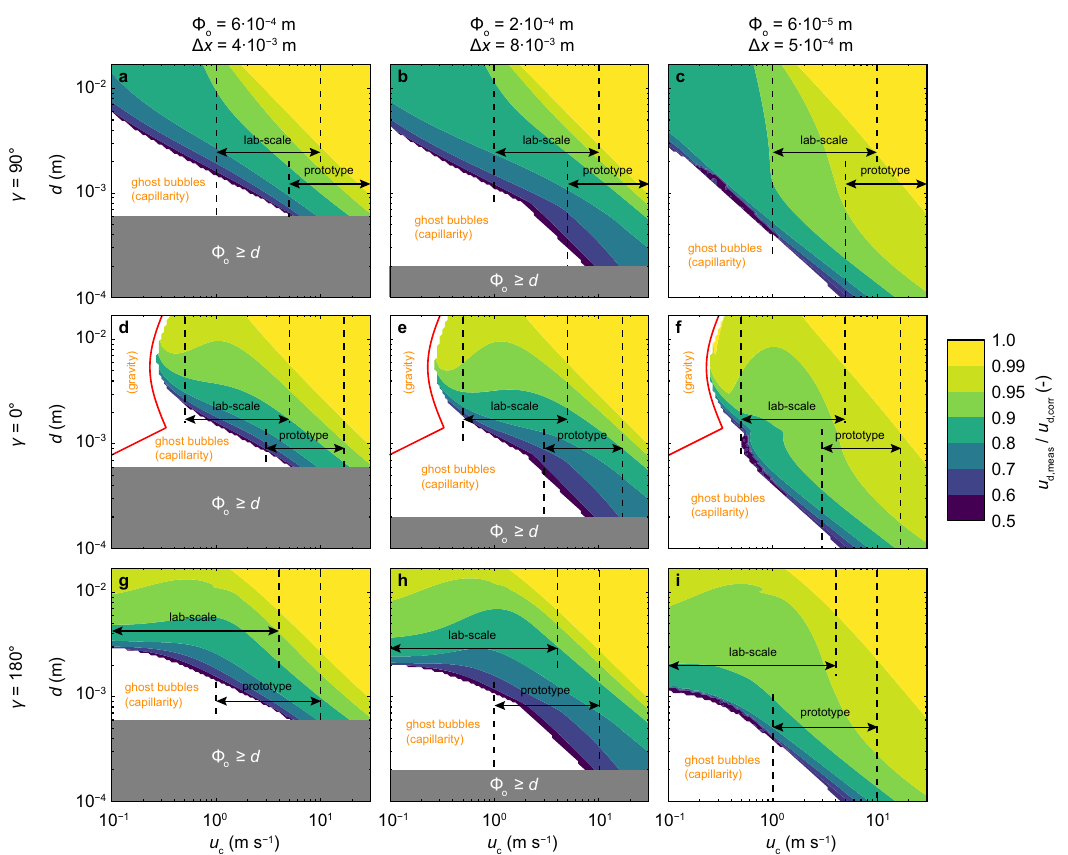
Fig. 5 Estimated velocity underestimation due to bubble – probe interaction for gas – liquid fl ows depending on the Sauter diameter and the instantaneous continuous-phase velocity. Top row corresponds to horizontal ( γ = 90 ∘ ), the middle row to vertical downwards fl ows ( γ = 0 ∘ ) and the bottom row to vertical upwards fl ows ( γ = 180°). Columns compare different probe geometries. a , d , g conductivity probe designed to resist high velocities (this study). b , e , h conductivity probe designed for small to intermediate velocities 65 . c , f , i fi ne fi ber-optical probe for fl ows around ship hulls 66 . Typical ranges for u c are indicated for comparison. The white areas represent u d,1,trail < 0, the solid red line in ( d – f ) indicates the bubble rise